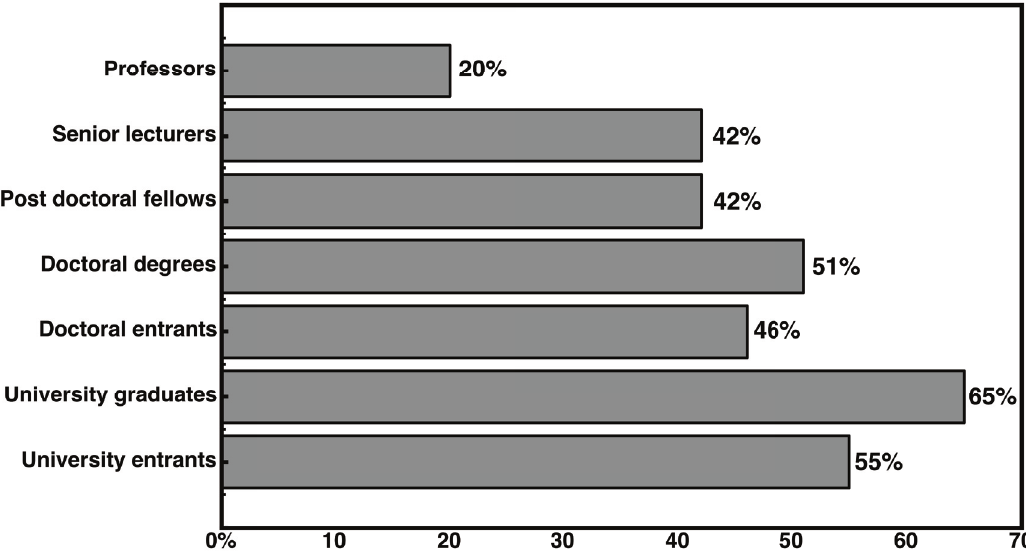
Figure 2. Vertical gender balance in Swedish academia. Data obtained from ref. 14.